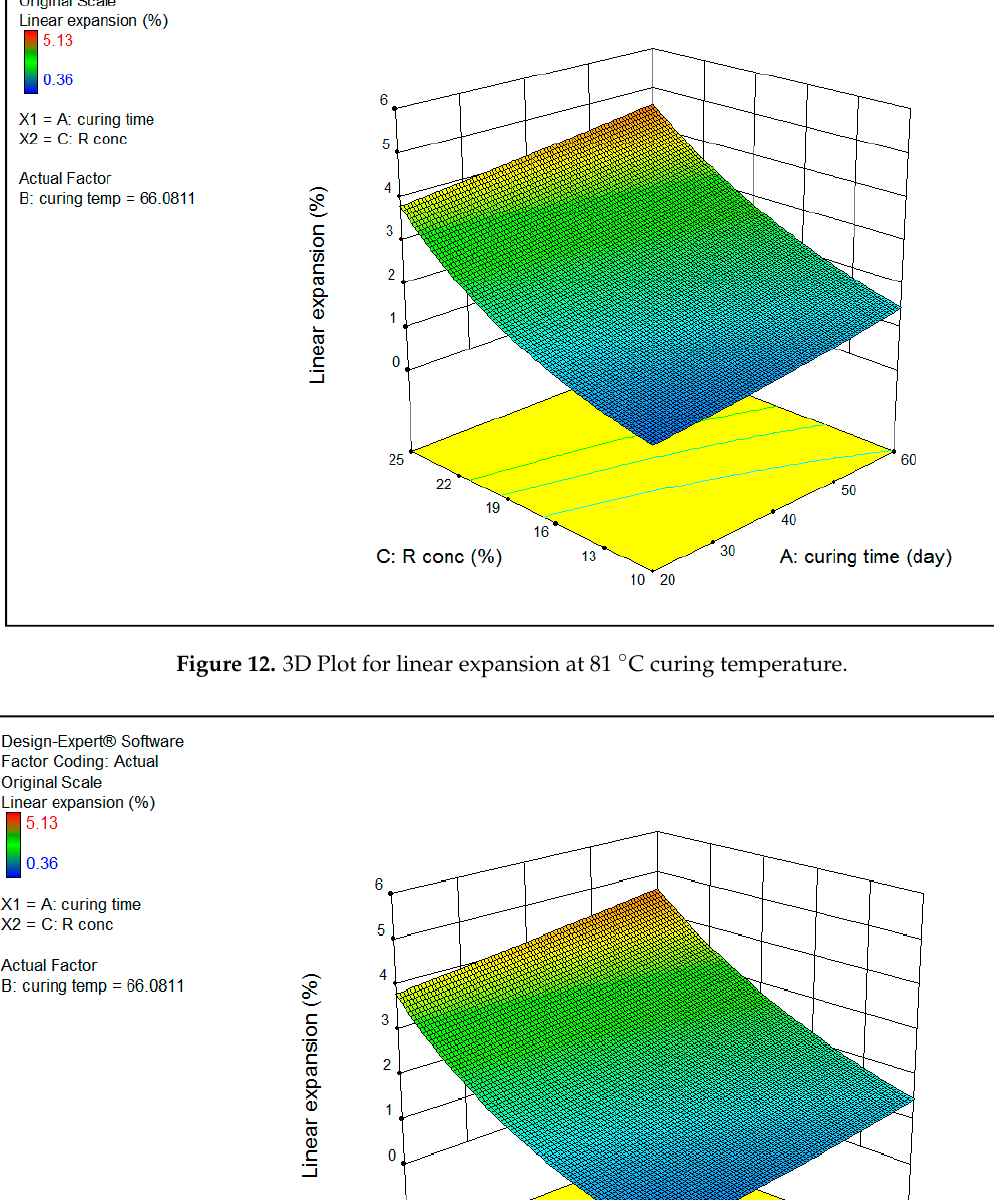
14 of 16 Figure 11. Predicted versus actual.